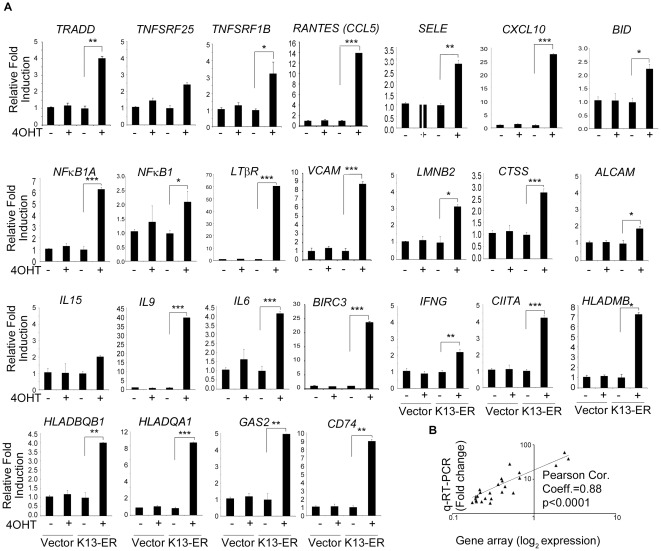
Validation of gene array data by qRT-PCR.(A) Twenty five genes from NF-κB, cytokine, and inflammatory pathways were randomly selected and their relative mRNA levels in mock and 4OHT-treated vector and K13-ERTAM-expressing BCBL1 cells were examined using qRT-PCR. Real-time PCR reactions were performed in triplicate and the data presented as fold change mean ±S.E in target gene expression (*p<0.05; Student's t-test). (B) Pearson Correlation coefficient between gene expression array and real time PCR showed a significant agreement (Correlation coefficient 0.88; p<0.0001).